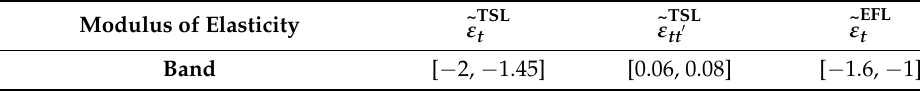
Figure 7. Forecast curve of PV output. Table 3. Price elasticity of EFL-TSL